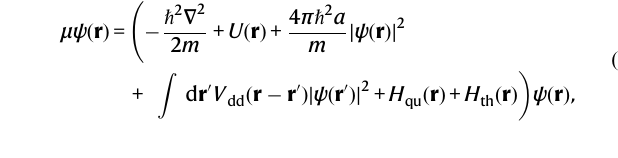
Fig. 3 | Emergence of density modulations in trapped condensates. Our mea- suredaxialdensity ∣ ψ ∣∣ ( z ) ∣ 2 (orangepoints),observedfor T =76.5nKand N c =13,400 condensateatoms,demonstratestheformationofasupersolidstateandagreeswell withthenumericalsimulationoftheTeGPE(redline).Ontheotherhand,equivalent simulations at zero temperature (blue line) disagree qualitatively and instead yield an unmodulated super fl uid phase. The vertical error bars indicate the statistical uncertainties (one standard deviation) of the experimentally measured